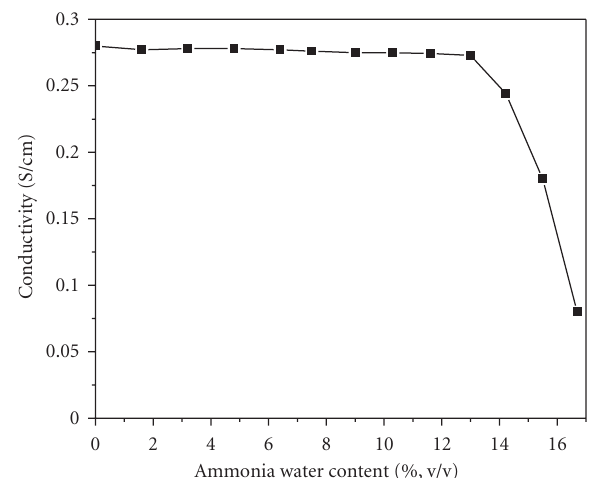
Figure 3: The pH of PEDOT:PSS solutions with di ff erent AW dop- ing ratios.